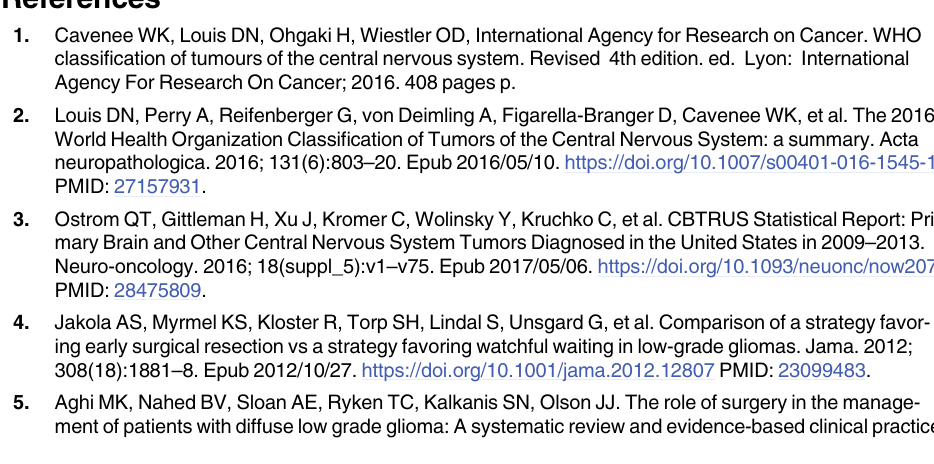
S1 Fig. Multivariate analysis for determinants of treatment receipt comparing patients who received surgery alone with patients that received surgery and adjuvant treatment (either surgery plus chemotherapy, surgery plus radiation, or surgery plus chemotherapy and